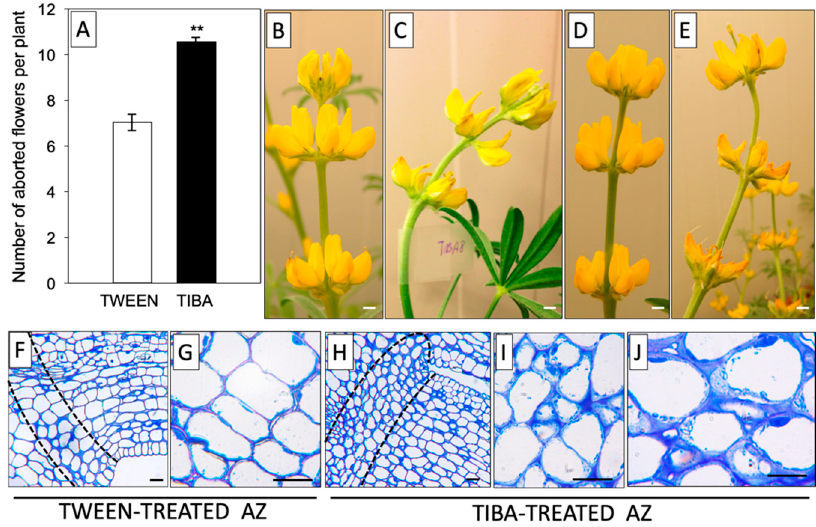
Figure 1. The inhibitor of auxin transport induced flower abscission in yellow lupine. For the analyses, a solution of TIBA (2,3,5-triiodobenzoic acid, 0.05 mM in 0.05% Tween 20) or 0.05% Tween 20 was applied directly to the inactive flower abscission zone (AZ). The flower abscission rate was monitored for 120 h after the TIBA or Tween 20 application ( A ). Distortion of the stem evoked by inhibition of indole-3-acetic acid (IAA) polar transport; pictures were taken 8 h ( C ) or 24 h ( E ) after TIBA treatment and 8 h ( B ) or 24 h ( D ) after Tween 20 application. Histological analysis was made to compare the AZ cells treated with Tween 20 solution ( F – G ) and AZ cells activated using TIBA ( H – J ). Observations were performed 24 h after the application of substances. The dotted lines delimit the AZ regions. At least 15 plants were used in the physiological assay. Values are presented as the mean ± SE. The experiment was performed in three independent biological replications. Scale bars: 10 mm ( B – E ) and 40 µM ( F – J ).